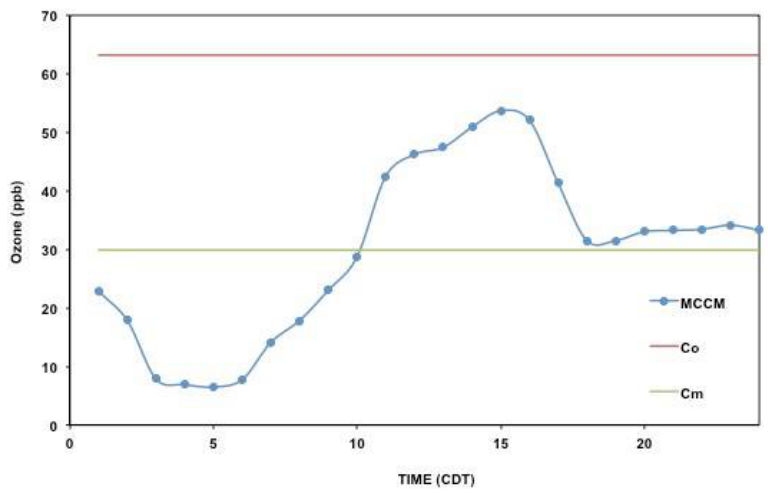
Figure 3. The average passive monitoring values at any site (Co) and the Mesoscale Climate and Chemistry Model (MCCM) average (Cm), which is obtained by averaging the profile with the hourly means from MCCM calculated over the two-month passive sampling period.